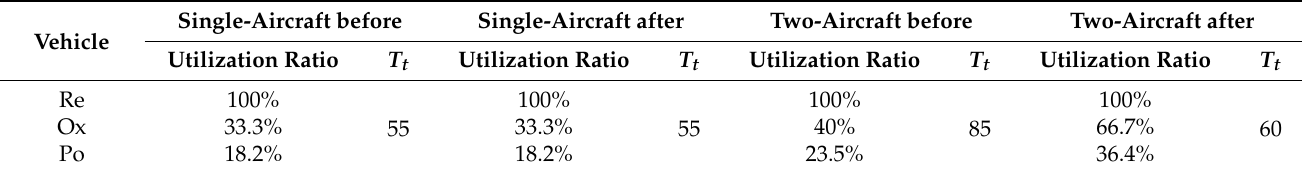
Table 6. Statistics of support vehicle utilization and completion time of three operations before and after scheduling